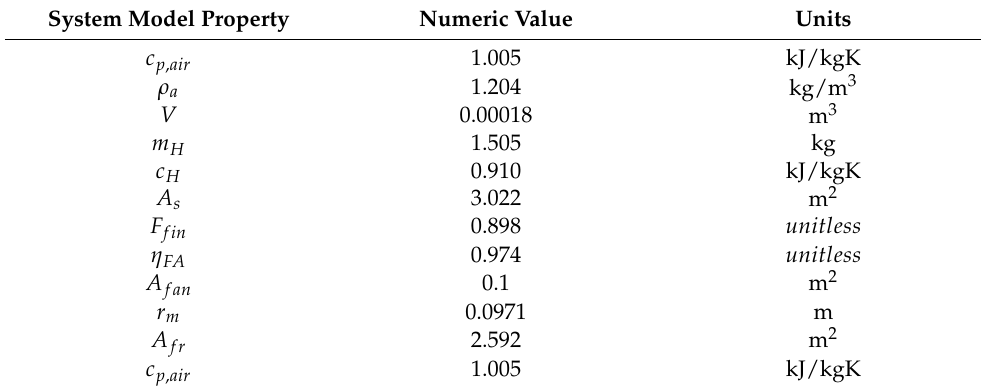
Table A1. System property values and units.